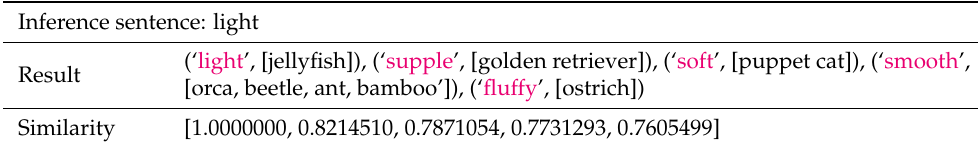
Table 16. Semantic reasoning result of